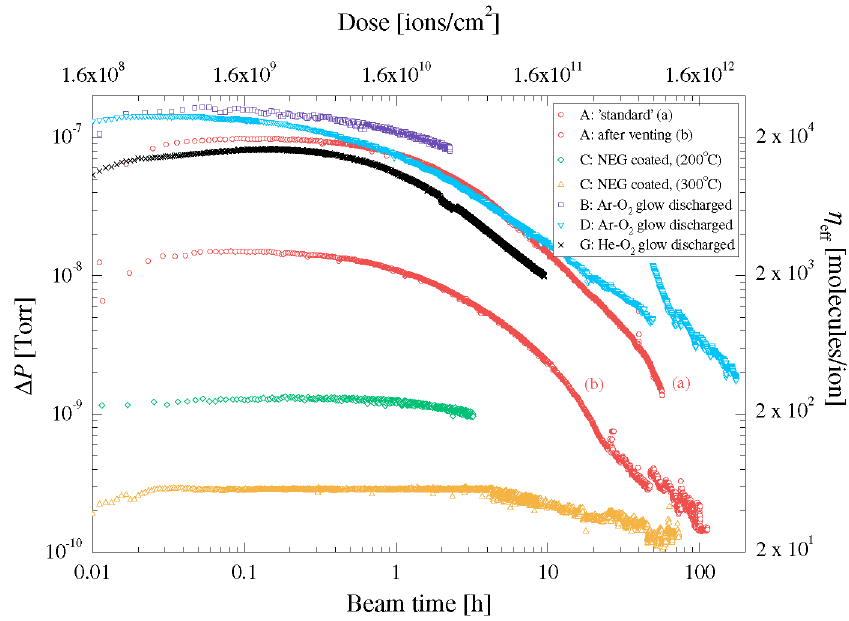
FIG. 10. (Color) Beam cleaning measurements for five different stainless steel vacuum chambers continuously bombarded with 1 : 5 (cid:2) 10 9 Pb 53 (cid:1) ions (per shot) under (cid:6) (cid:6) 89 : 2 (cid:7) grazing incidence. The results obtained for Ar - O and He - O glow-discharged vacuum 2 2 chambers and a NEG-coated chamber, activated at 200 (cid:7) C and 300 (cid:7) C , are compared with an untreated (‘‘standard’’) vacuum chamber [curve (a)]. This chamber was vented after 60 h bombardment (no flange was opened), pumped, baked, and measured again [curve (b)]. The calculated effective desorption yield (right axis) cannot be applied to the NEG-coated chamber